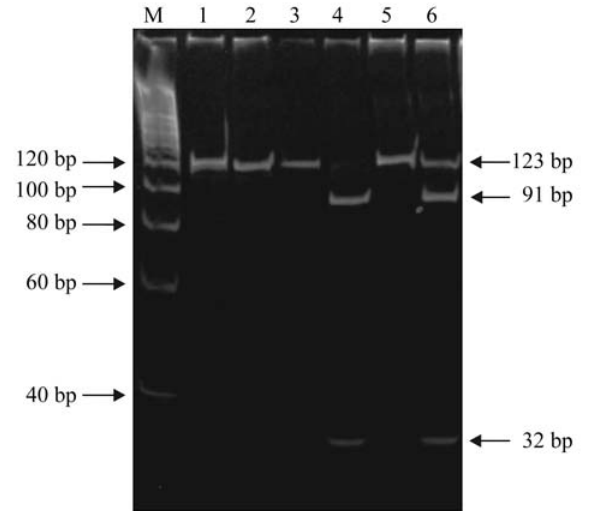
Figure1 -DetectionoftheG → Tmutationatcodon12of HRAS oncogene by PCR-RFLP analysis. On a 10% polyacrylamide gel: line M, molecular weight marker; lanes 1 and 2, positive control (T24 cell line DNA), undi - gested and Mst I - digested, respectively; lanes 3 and 4, sample without the mutation, undigested and digested, respectively; lanes 5 and 6: sample with the mutation, undigested and digested, respectively.